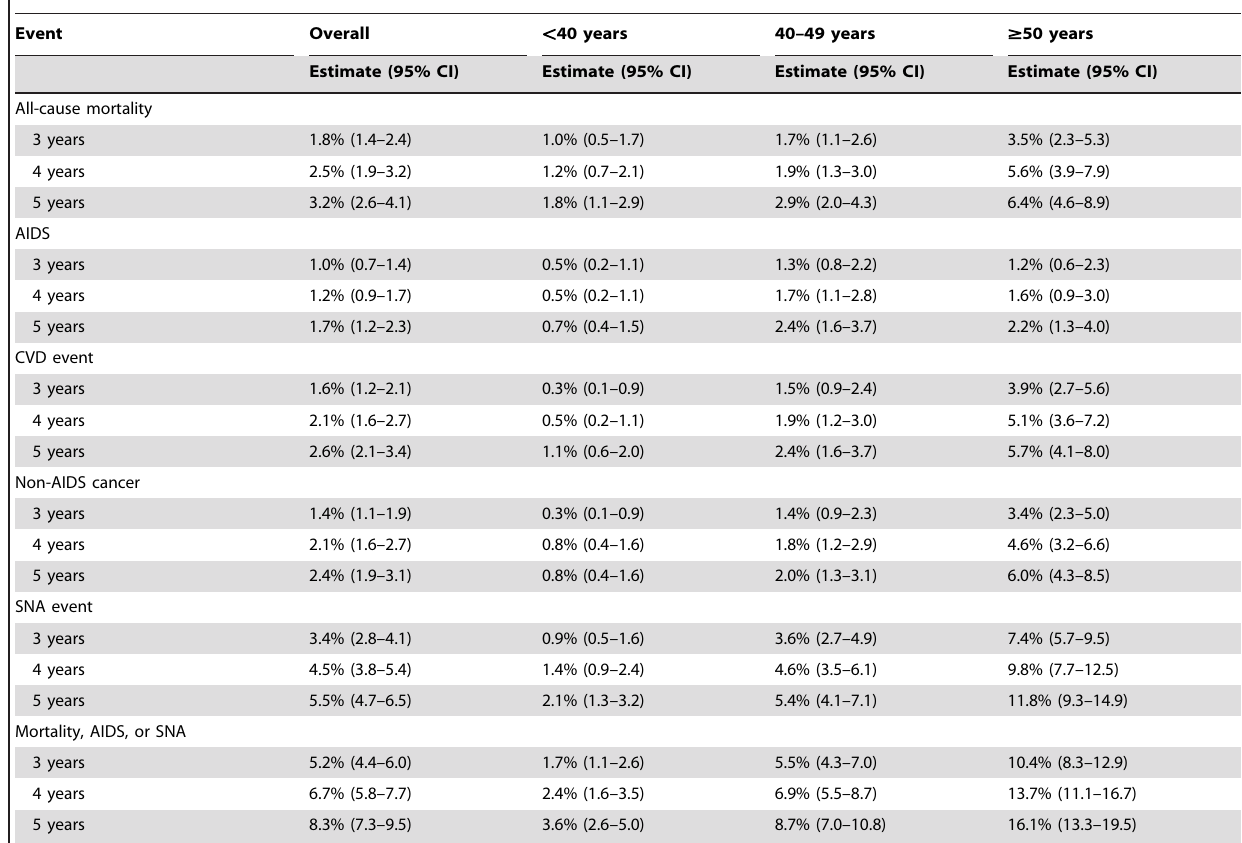
Table 3. Kaplan-Meier probabilities for events at 3, 4, and 5